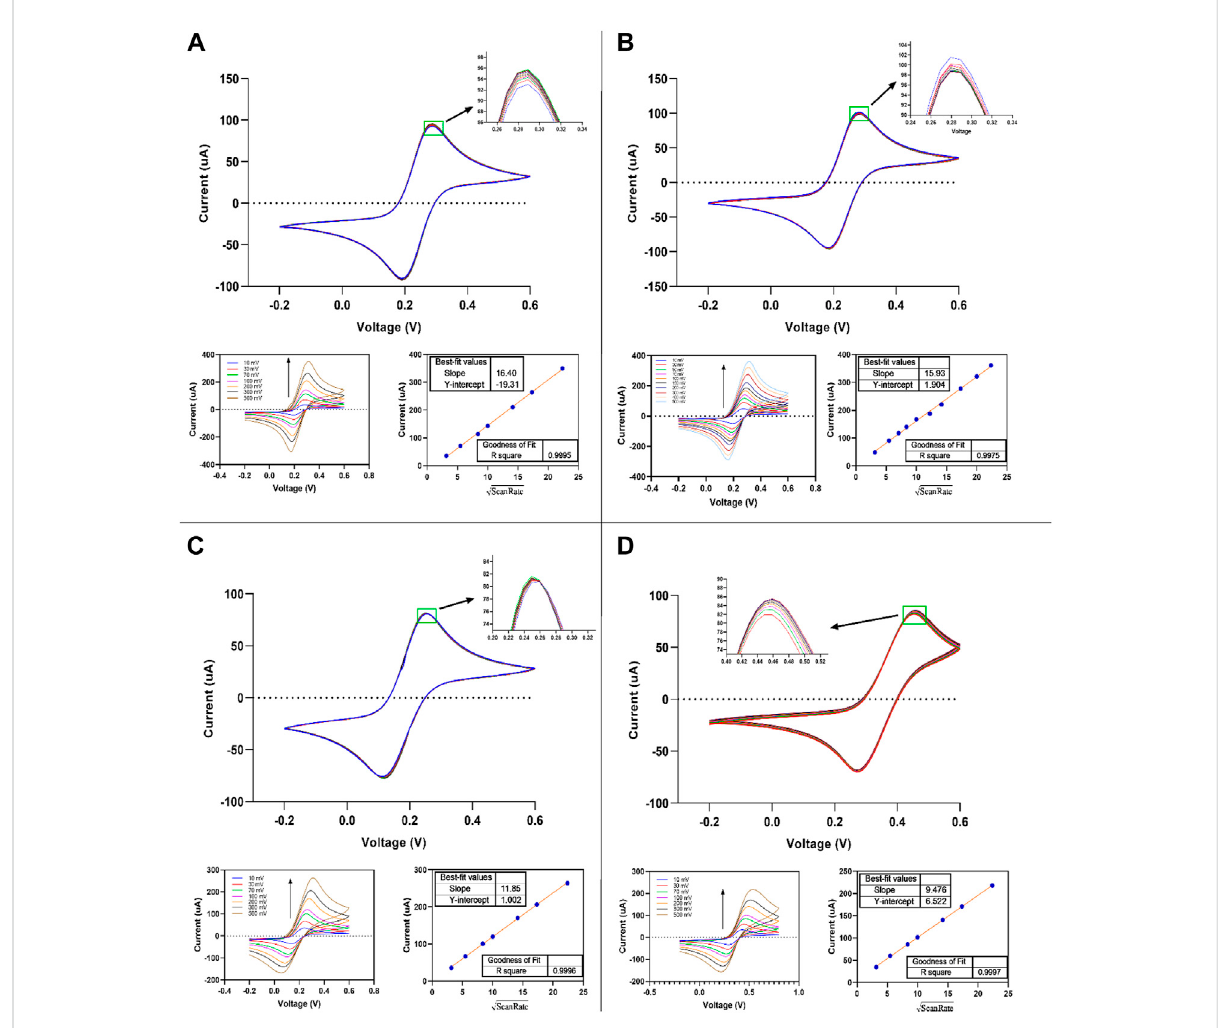
FIGURE 8 Cyclicvoltammogramsoffabricatedthin- fi lmgoldSPEmeasuredin0.5 mMK 4 Fe(CN) 6 /K 3 Fe(CN) 6 aqueoussolution+ (A) 1MKCl, (B) 1 MKNO 3 , (C) 1X PBS, and (D) 0.1 M H 2 SO 4 . Scan rate: 10 – 500 mV s − 1 .